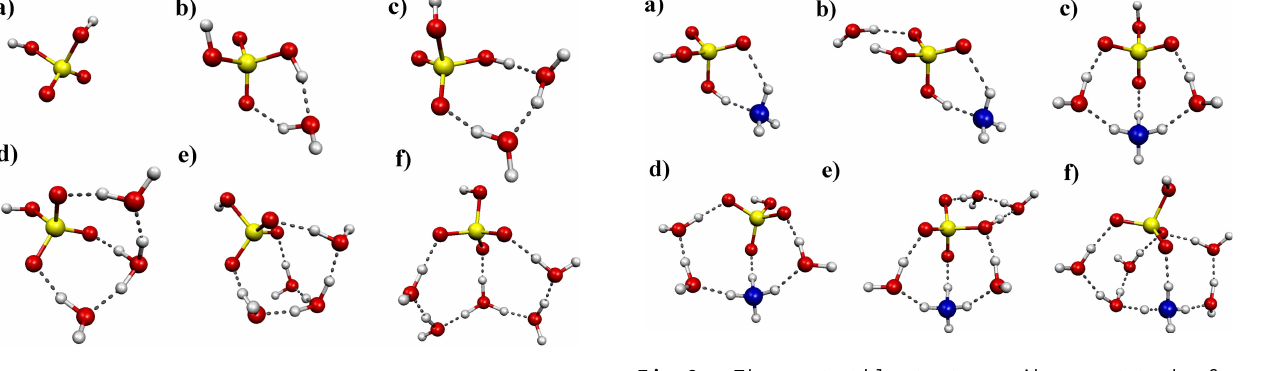
Fig. 1. The most stable structures with respect to the forma- tion free energy 1G (at T = 298 . 15K and P = 1atm) for clus- ters consisting of one sulfuric acid and 0–5 water molecules: (a) H 2 SO 4 , (b) H 2 SO 4 · H 2 O, (c) H 2 SO 4 · ( H 2 O ) 2 , (d) H 2 SO 4 · ( H 2 O ) 3 , (e) H 2 SO 4 · ( H 2 O ) 4 , (f) H 2 SO 4 · ( H 2 O ) 5 .